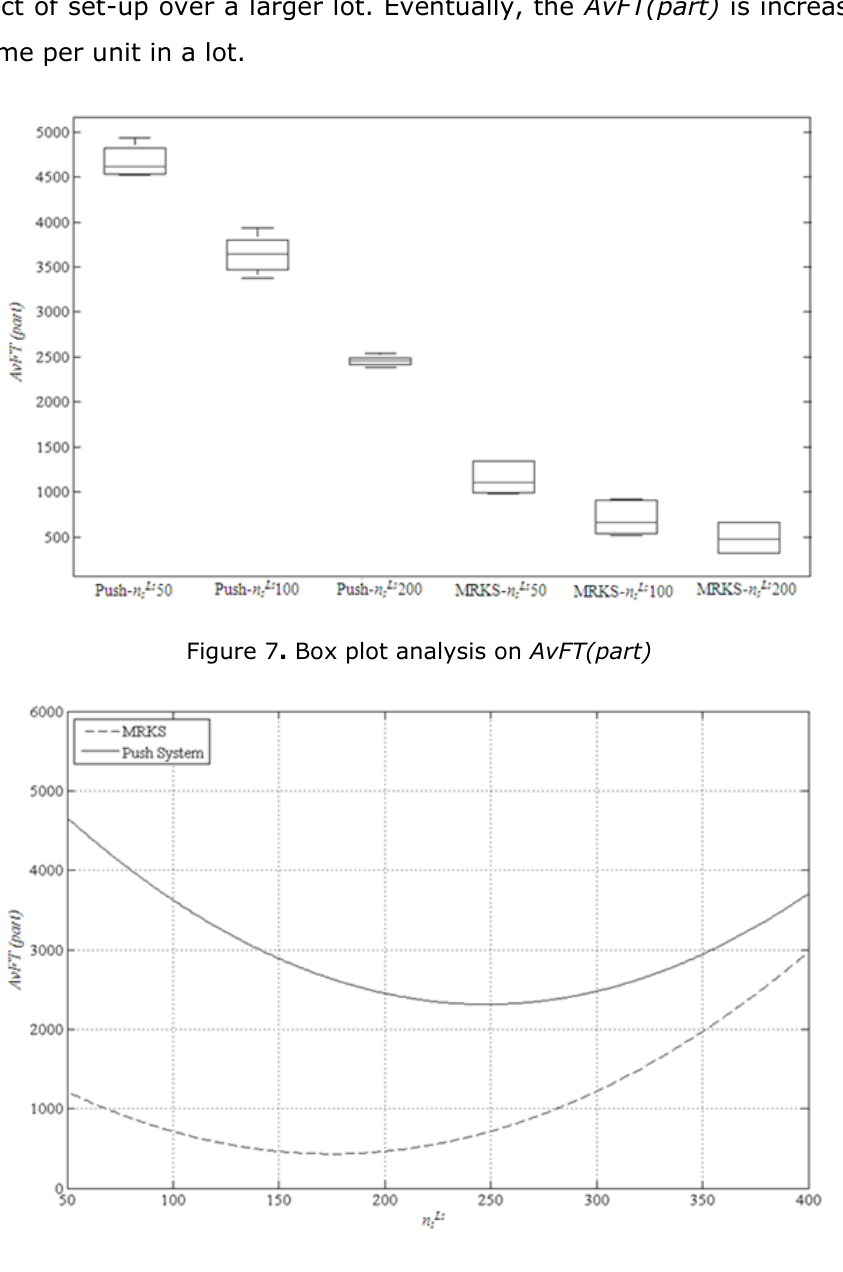
Figure 8. Effect of n sLs on AvFT(part